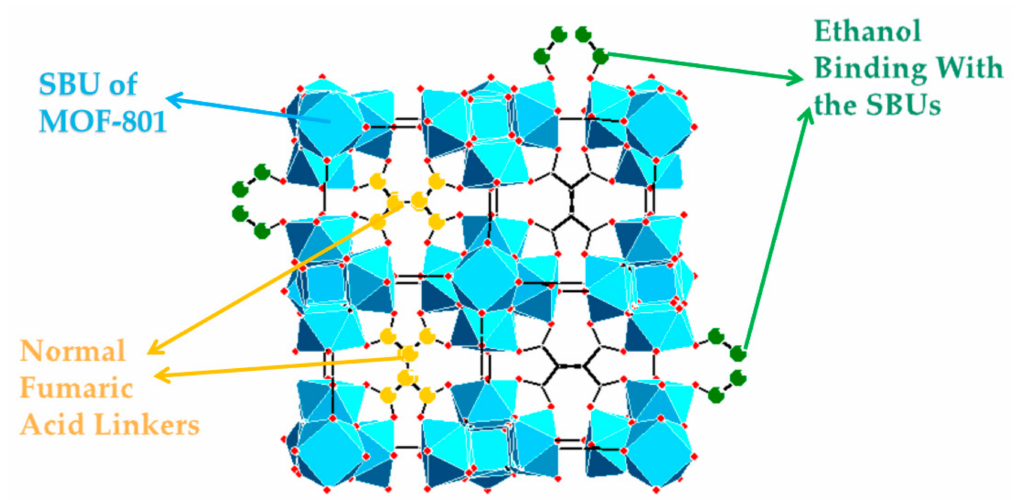
Figure 7. The different bonding modes between Zr ions and the organic molecules in MOF-801. All hydrogen atoms are omitted. Both yellow spheres and green atoms represent carbon atoms. They are shown in different colors just for clarification